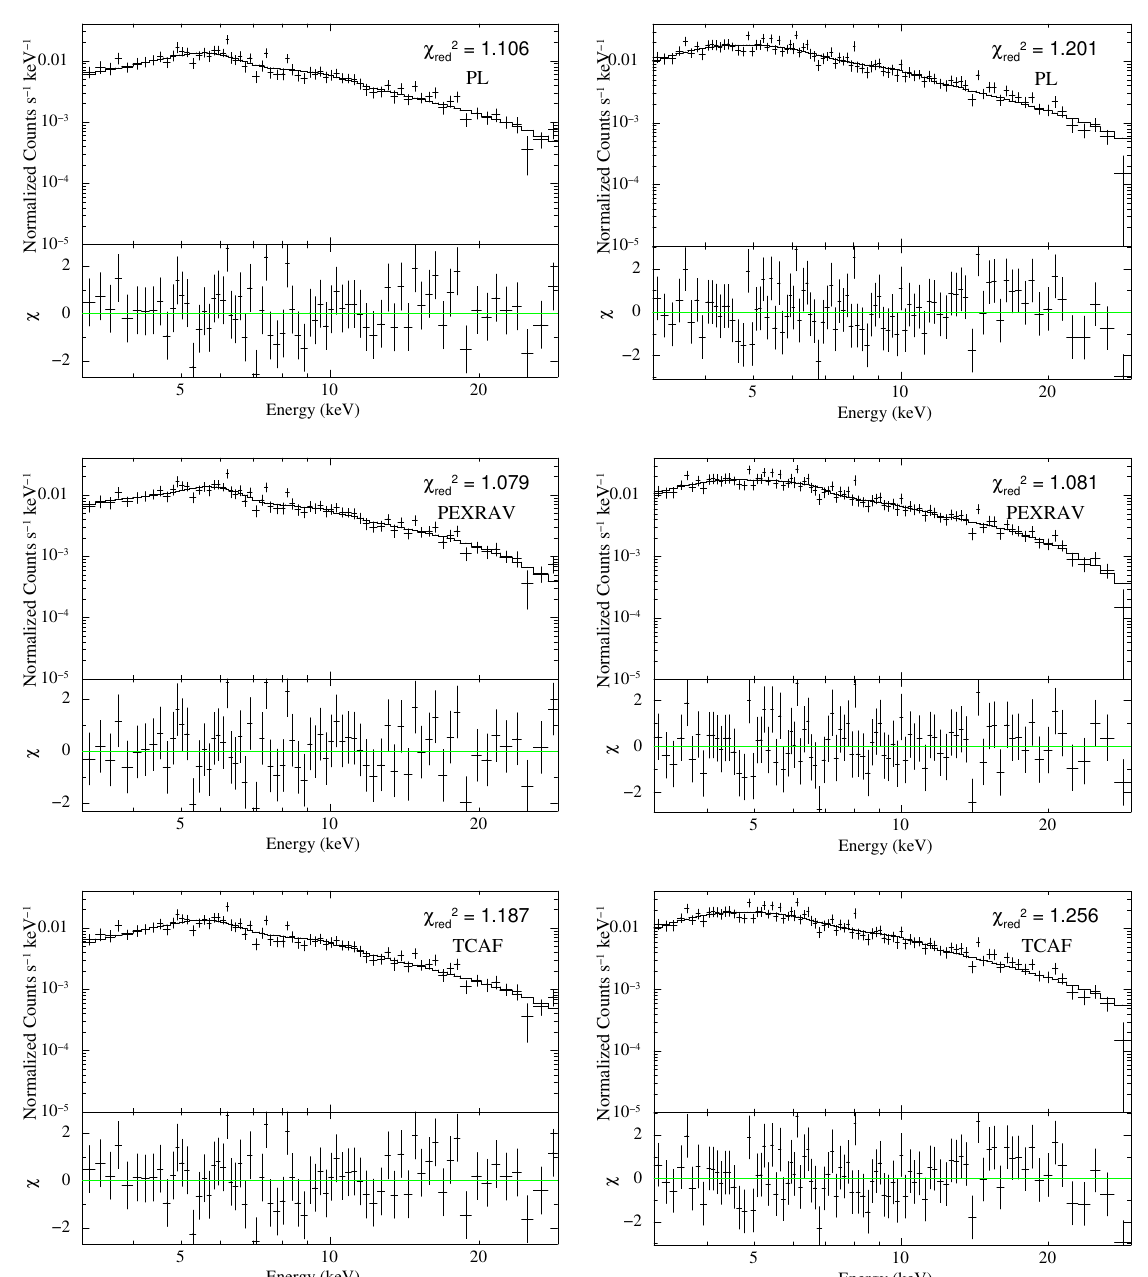
Figure 2. Sample fit of 3–30 keV spectra with PL, PEXRAV , and TCAF models for OBSIDs 60001041002 ( left panel ) and 60001041003 ( right panel ) along with the